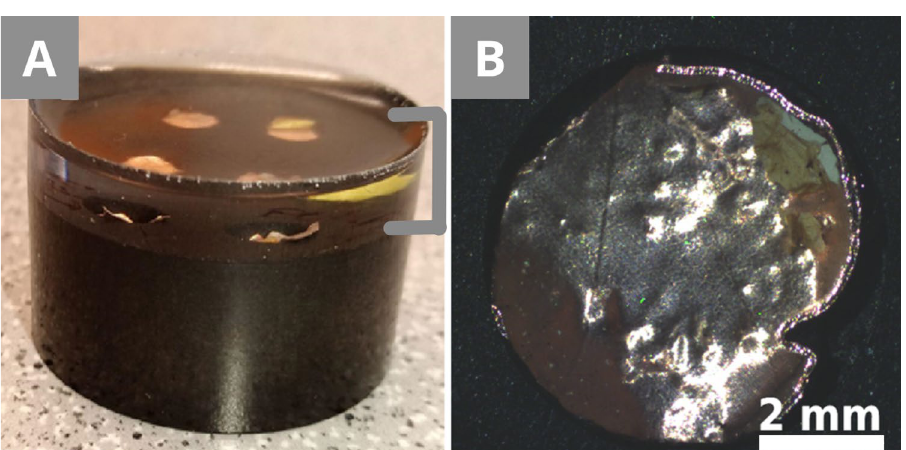
Figure 7. Preparation B. (A) Transparent resin fills the holes made in the conductive resin. This layer can be reduced to its minimum by filling only the holes. The thickness of the transparent layer of the cross-section (marked grey) and the conductive resin can be used for automatic polishing. (B) The sample is fixed with copper